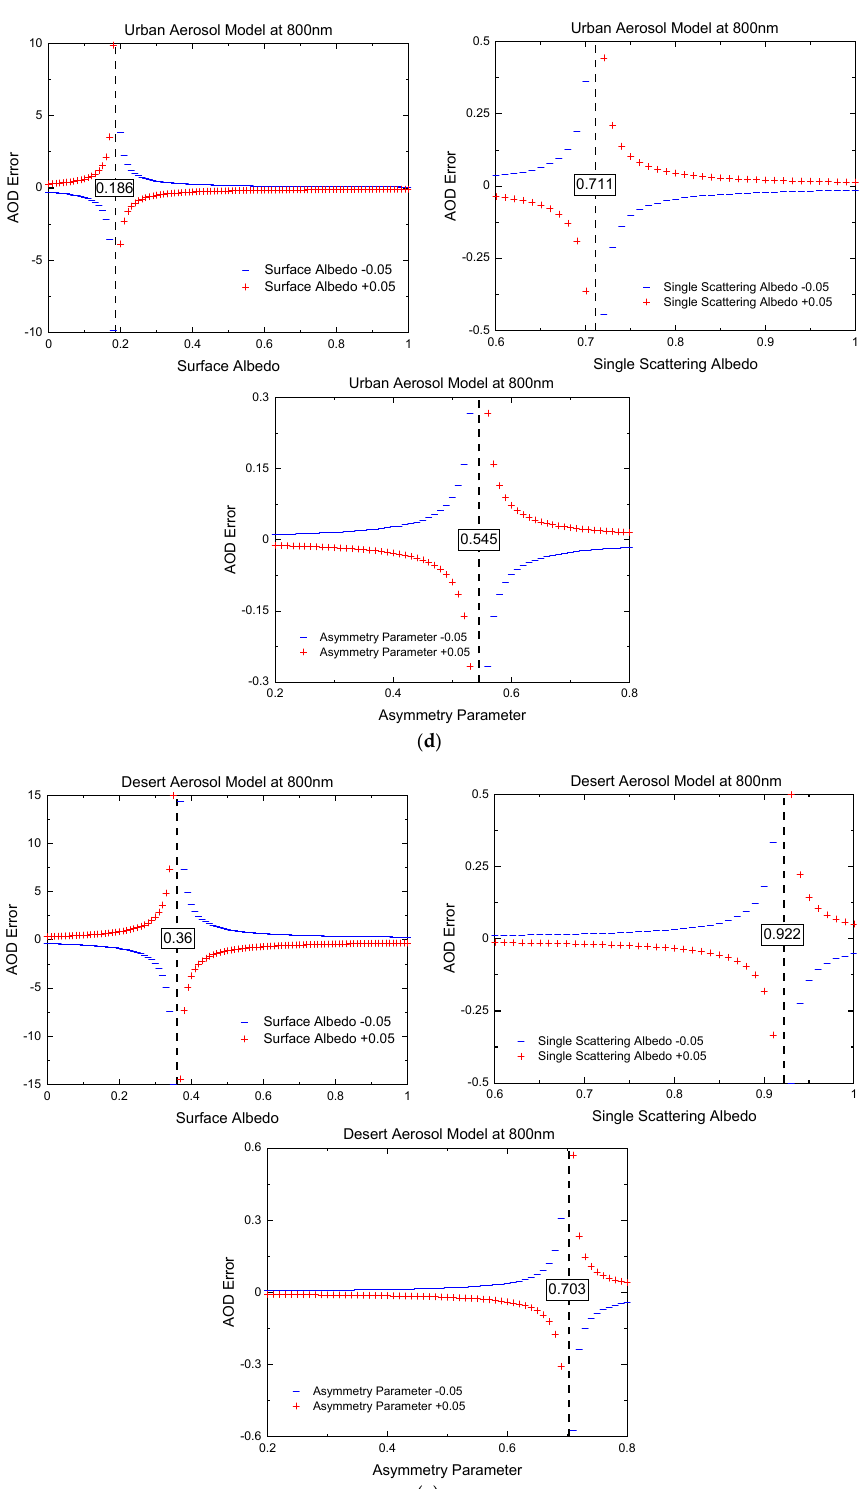
Figure 3. AOD errors for an AOD of 0.08 as function of surface albedo (top left), single scattering albedo (top right) and asymmetry parameter (bottom) for a continental clean ( a ), continental average ( b ), continental polluted ( c ), urban ( d ) or desert ( e ) aerosol model at the wavelength of 800 nm. The red plus sign denotes an overestimation of surface albedo (single scattering albedo or asymmetry parameter) by +0.05 and the blue minus sign denotes an underestimation of surface albedo (single scattering albedo or asymmetry parameter) by − 0.05. The critical values are given in the box along with the dashed line.